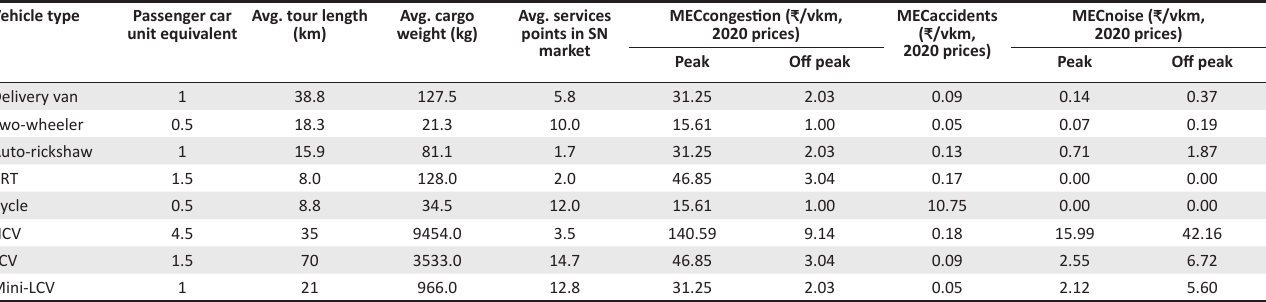
TABLE 1: Summary of the freight delivery pattern based on modal split and marginal external costs in Delhi. Vehicle type Passenger car Avg. tour length Avg. cargo Avg. services unit equivalent (km) weight (kg) points in SN